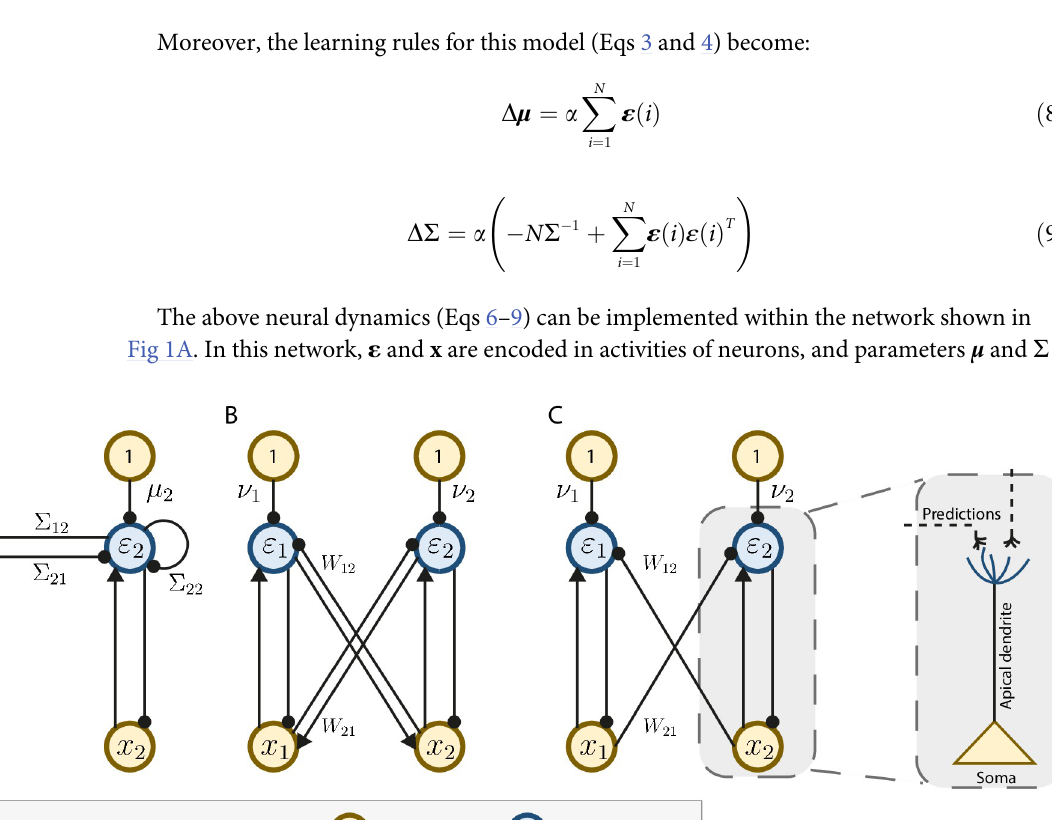
Fig 1. Neural implementations of the single-layer covPCNs using error neurons. x For simplicity we show the case where the input patterns have only 2 dimensions, corresponding to 2 value and error neurons. A: explicit covPCN originally proposed in [16]. B: Implicit covPCN. C: Dendritic covPCN with direct structural mapping to a pyramidal cell. Unlabeled connections have strengths 1.